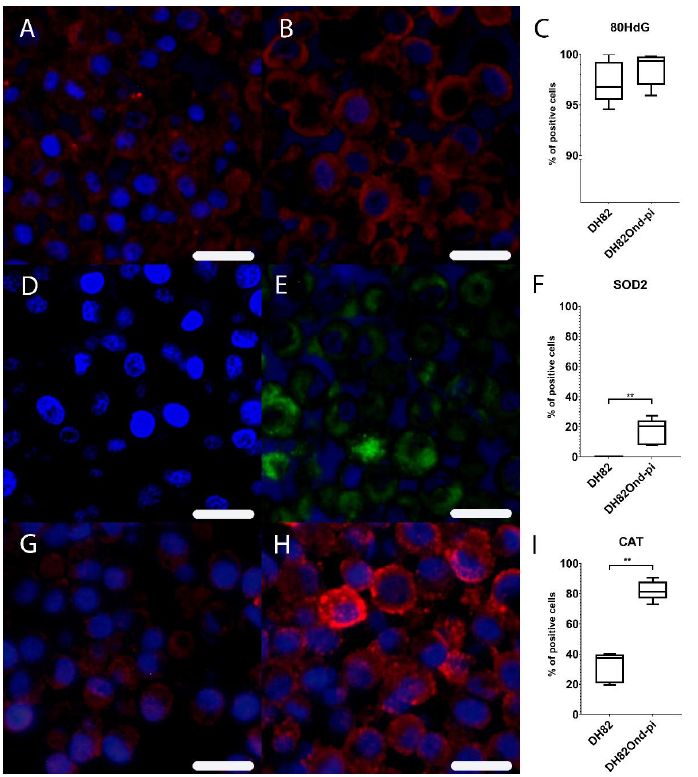
Figure 1. Immunofluorescence analysis revealed a lower expression of markers associated with oxidative stress in non-infected ( A,D,G ) compared to persistently canine distemper virus (CDV) infected ( B,E,H ) DH82 cells. Staining for 8OHdG (Cy3, red) and bisbenzimide (nuclei, blue) revealed a similar expression in non-infected ( A ) and persistently CDV-infected ( B ) DH82 cells as graphically shown in ( C ). Staining for superoxide dismutase (Cy2, green) and bisbenzimide (nuclei, blue) showed a significantly lower expression in non-infected ( D ) compared to persistently CDV-infected DH82 ( E ) cells as graphically depicted in ( F ). Staining for catalase (Cy3, red) and bisbenzimide (nuclei, blue) demonstrated a significantly lower expression in non-infected ( G ) compared to persistently CDV-infected ( H ) DH82 cells as graphically shown in ( I ). Bar = 20µm. ( C ), ( F ) and ( I ) display box and whisker plots with median values, quartiles and maximum and minimum values. Significant differences ( p ≤ 0.05, Mann–Whitney U-test) are labeled by asterisks (** p ≤ 0.01). Immunofluorescence for 8OHdG lacked a significant difference ( p = 0.5476) in the percentage of positive cells between non-infected (median = 96.80%, range: 94.58–100.00%) and DH82Ond pi pellets (median = 99.33%, range: 95.94–99.79%) (Supplementary Table S1). Immunofluorescence for SOD2 displayed a significantly ( p = 0.0079) increased percentage of positive cells in DH82Ond pi pellets (median = 20.39%, range: 7.75–27.30%) compared to non-infected DH82 pellets (median = 0.00%, range: 0.00%–0.47%) (Supplementary Table S1). Immunofluorescence for CAT revealed a significantly ( p = 0.0079) increased percentage of positive cells in DH82Ond pi pellets (median =